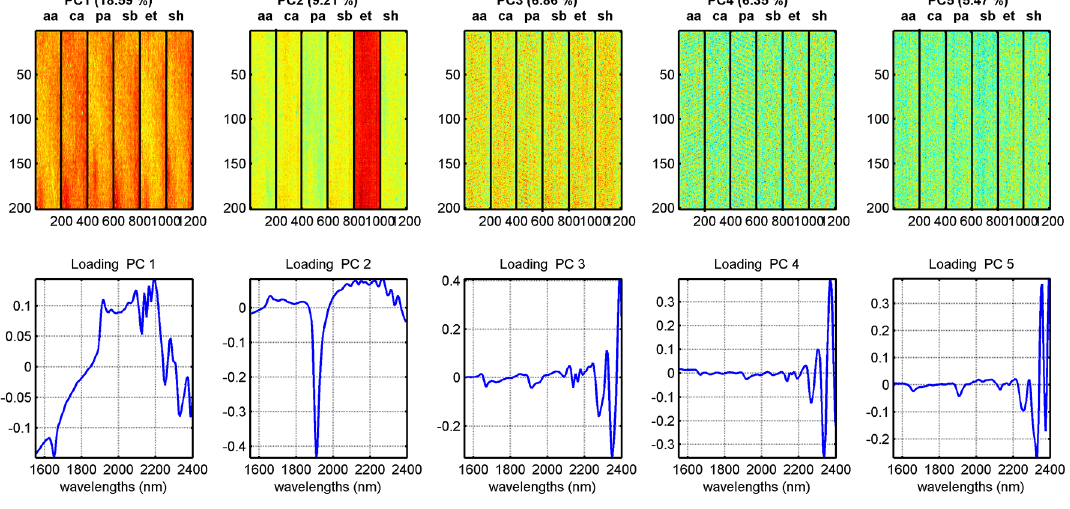
Figure 6. Scores images and loadings of PCA performed with PET samples exposed for 96 h to chemical agents (order in the illustration: ascorbic acid - aa, citric acid - ca, phosphoric acid - pa, sodium bicarbonate - sb, ethanol - et, and sodium hydroxide -